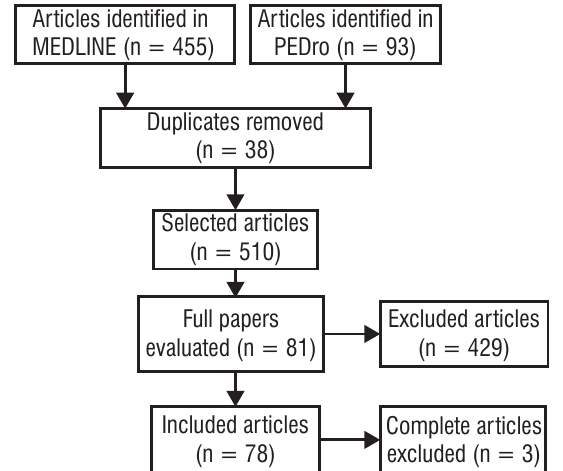
Figure 1 - Flowchart of study selection